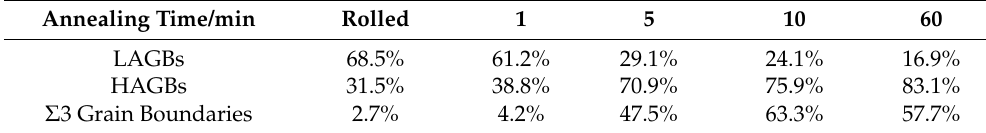
Figure 4. Grain boundary distribution of rolled and annealed copper foil. ( a ) Rolled sample; ( b ) 1 min; ( c ) 5 min; ( d ) 10 min; ( e ) 60 min. Table 1. Effect of annealing time on grain boundary fraction of copper